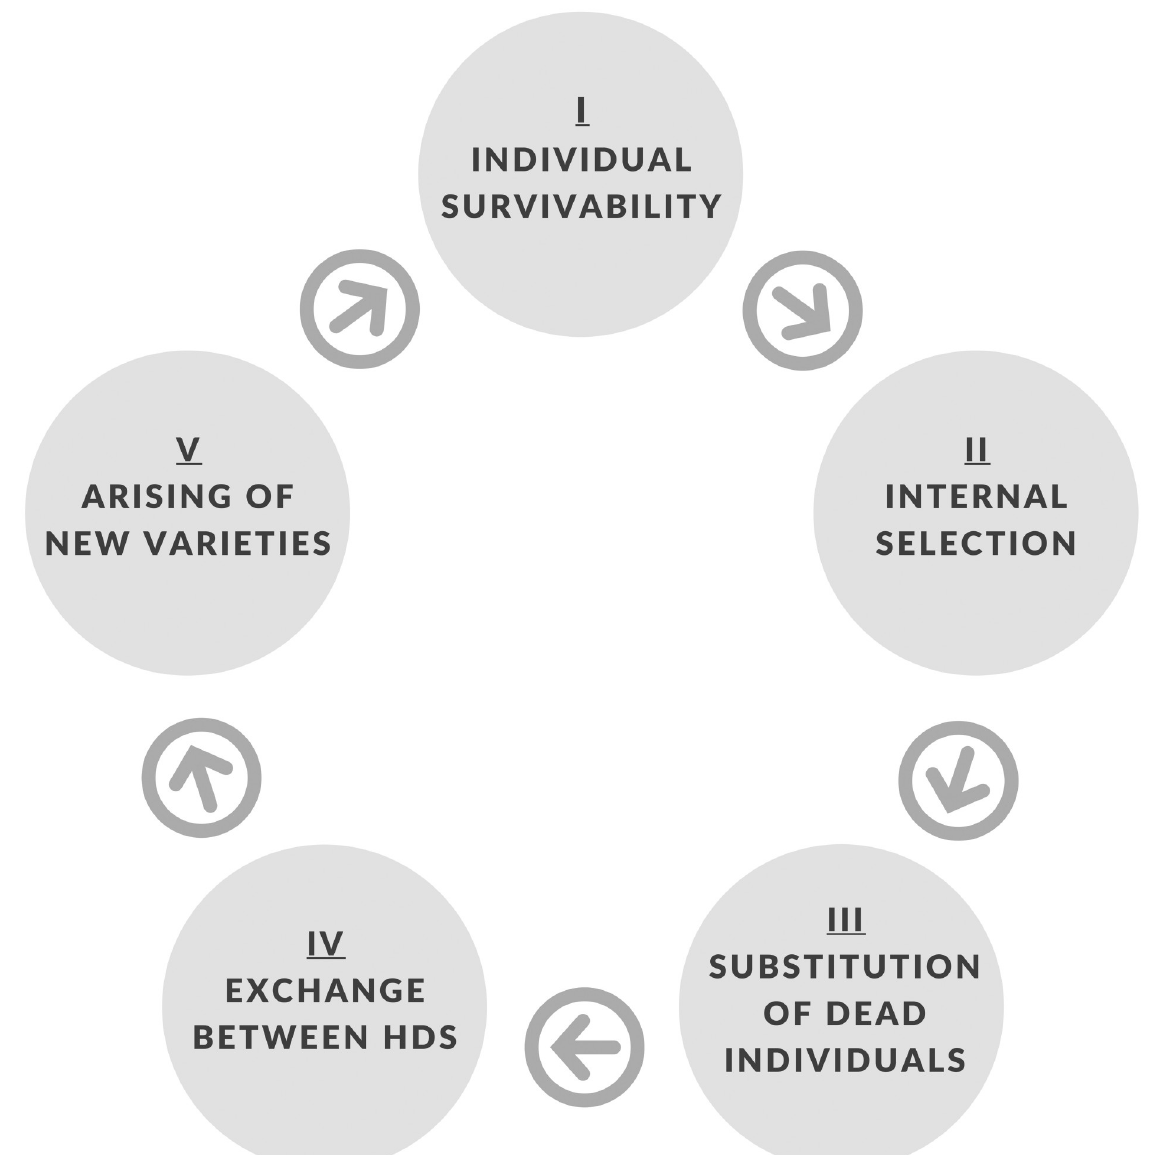
Fig 2. Flowchart of model